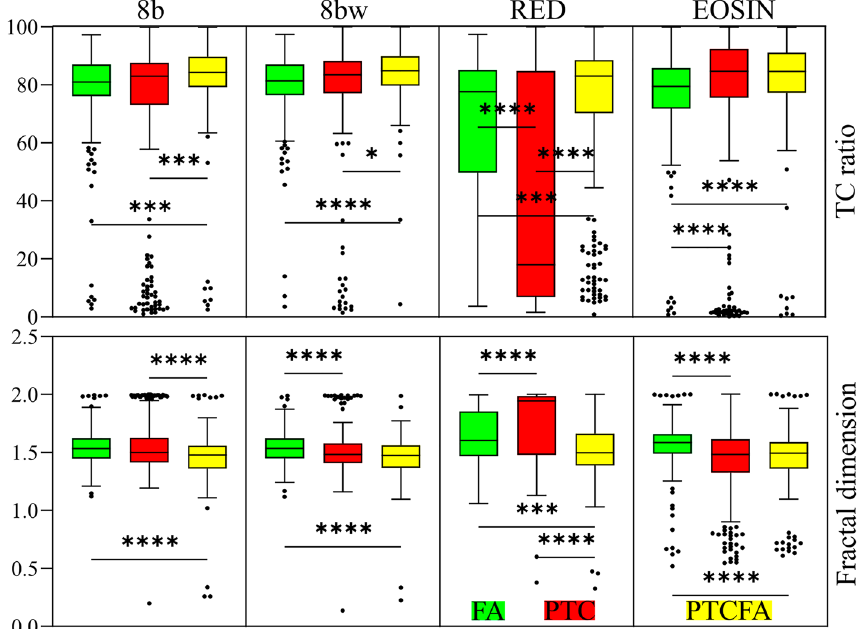
Figure 6. Statistical analysis for the case of binary image parameters extracted from the 1024 × 1024 pixels image tiles. (* p < 0.05, *** p < 0.001, **** p <